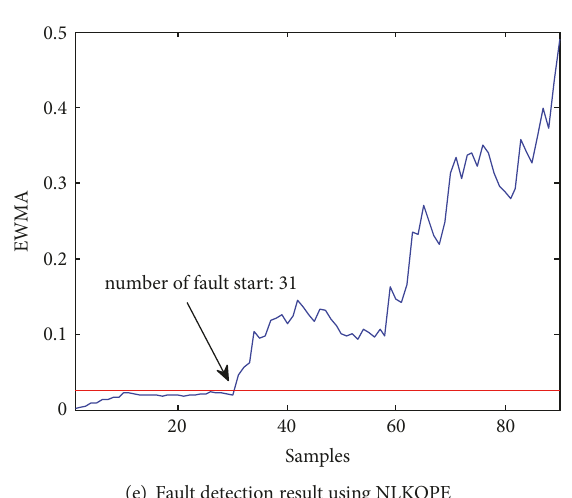
Figure 3: Monitoring charts: (a) KPCA, (b) KONPE, (c) NLOPE, (d) KGLPP, and (e)